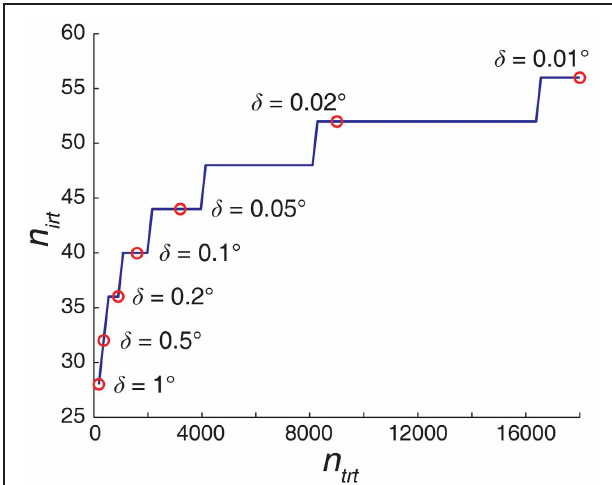
FIGURE 11 | Iterative Radon transform method markedly reduces the required number of Radon transforms ( n irt ) to achieve a given angle precision ( δ ) when compared with non-iterative method ( n trt ). The number of Radon transforms in the iterative algorithm increases logarithmically as δ becomes finer, compared to a linear increase for the traditional, non-iterative counterpart. As a result, there is an exponential increase in the computation speed for the iterative algorithm compared to the traditional non-iterative Radon transform methods. Results are based on Equations